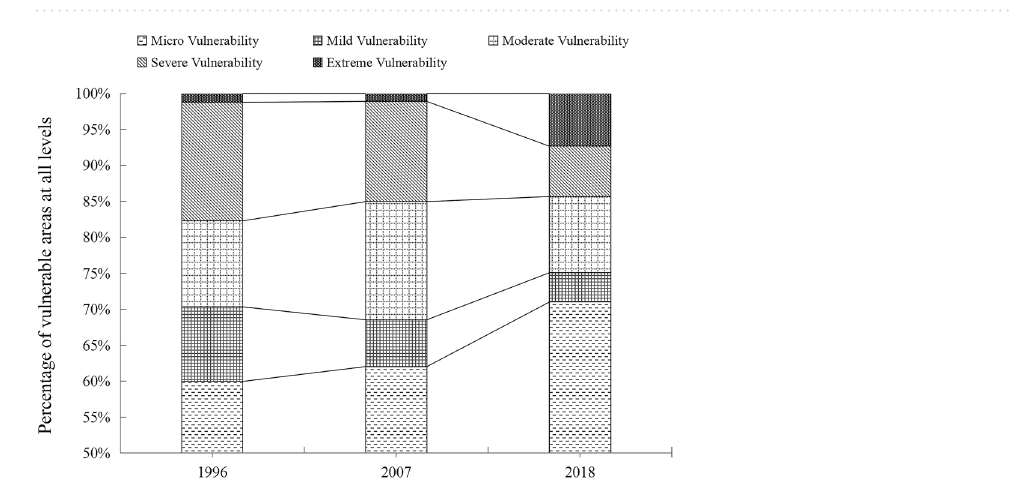
Figure 4. Proportion of the area of vulnerable districts at all levels in Shennongjia.